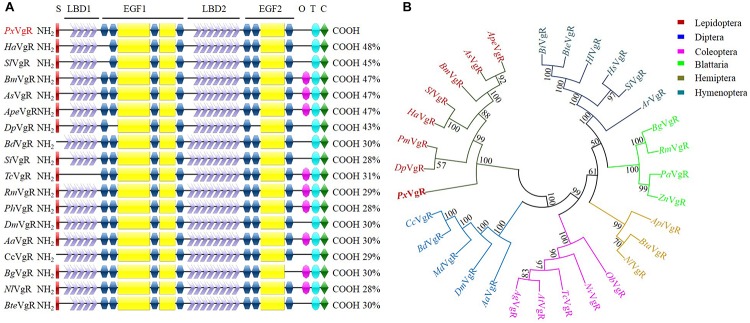
Sequence comparison and phylogenetic tree of insect VgRs. (A) Diagrammatic comparison of typical domains between PxVgR and other insects VgRs. The percentages (%) at the right of each sequence indicated the identify compared to PxVgR. (B) Phylogenetic tree of insects VgRs based on the method of neighbor-joining (NJ) with a bootstrap value of 1000 replicates. Sequences were deposited in the GenBank database, which included the VgRs of Plutella xyllostella (PxVgR, MN044389), Actias selene (AsVgR, AFV32171), Acyrthosiphon pisum (ApiVgR, XP_016657813), Aedes aegypti (AaVgR, AAK15810), Aethina tumida (AtVgR, XP_019881581), Anoplophora glabripennis (AgVgR, XP_018579962), Athalia rosae (ArVgR, XP_012266547), Antheraea pernyi (ApeVgR, AEJ88360), Bactrocera dorsalis (BdVgR, AGE83235), Bemisia tabaci (BtaVgR, ADM34986), Blattella germanica (BgVgR, CAJ19121), Bombus impatiens (BiVgR, XP_012241122), Bombus terrestris (BteVgR, XP_003402703), Bombyx mori (BmVgR, ADK94452), Ceratitis capitata (CcVgR, JAC05586), Danaus plexippus (DpVgR, OWR52293.1), Drosophila melanogaster (DmVgR, AAB60217), Habropoda laboriosa (HlVgR, KOC62359), Harpegnathos saltator (HsVgR, XP_011139074.1), Helicoverpa armigera (HaVgR, AGF33811), Musca domestica (MdVgR, XP_19894781), Nicrophorus vespilloides (NvVgR, XP_017771582), Nilaparvata lugens (NlVgR, ADE34166.1), Oryctes borbonicus (ObVgR, KRT81424), Papilio machaon (PmVgR, KPJ08910), Pediculus humanus corporis (PhVgR, XP_002423121.1), Periplaneta americana (PaVgR, BAC02725), Rhyparobia maderae (RmVgR, BAE93218), Solenopsis invicta VgR (SiVgR, AAP92450), Spodoptera litura (SlVgR, ADK94033), Tribolium castaneum (TcVgR, XP_15837722), Zootermopsis nevadensis (ZnVgR, XP_021934248). S, signal peptide; O, O-linked sugar domain; T, transmembrane domain; C, cytoplasmic domain.